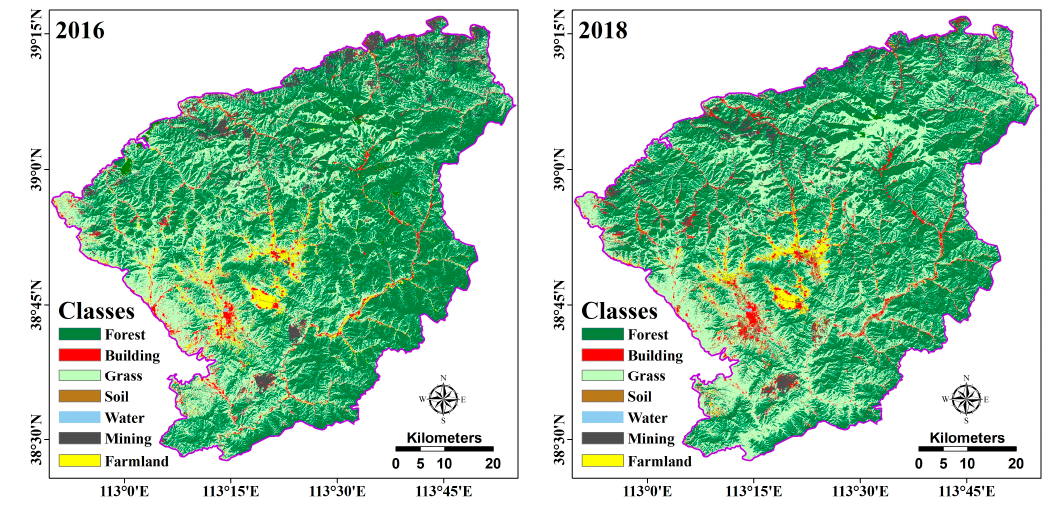
Figure 4. The Land Use / Land Cover (LULC) of Mount Wutai from 1987 to 2018.